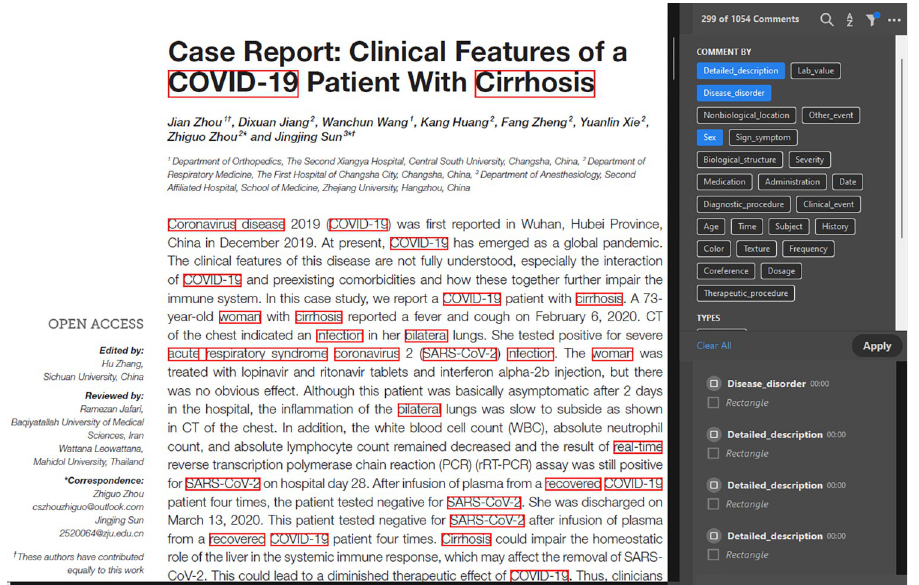
Fig 8. Annotations produced by our model in PDF